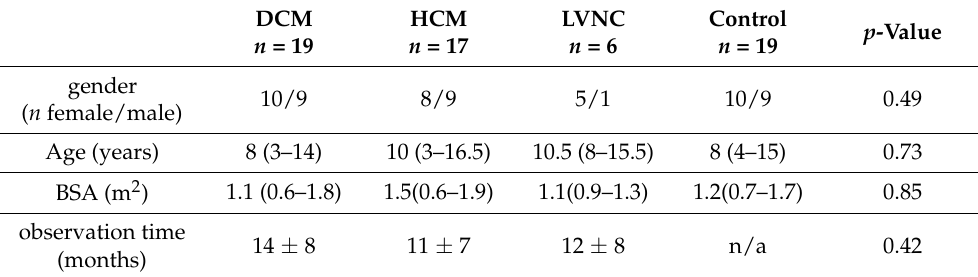
Table 1. Patients’